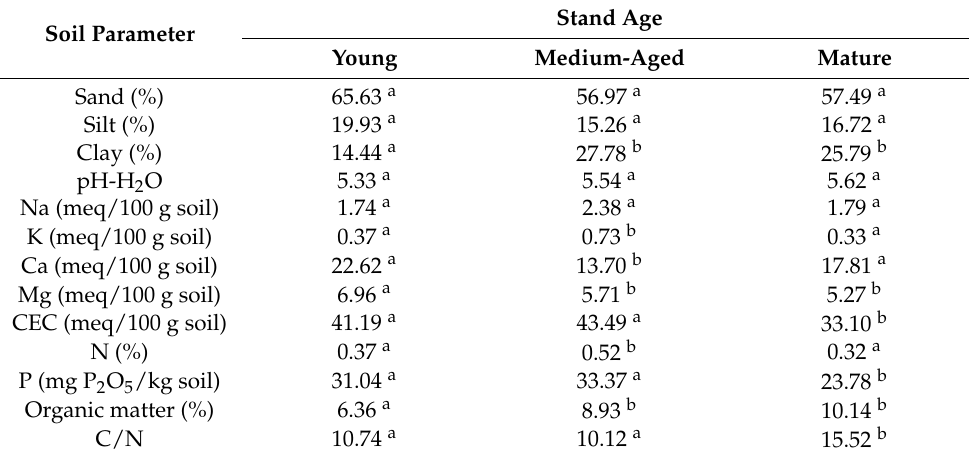
Table 1. Selected edaphic variables of young, medium-aged, and mature Pinus radiata stands in Menagesha Suba, central Showa, Oromia National Regional State,